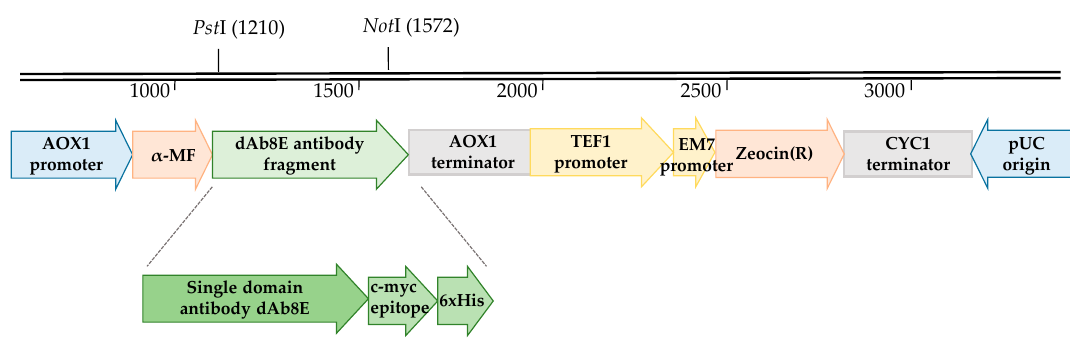
Figure 1. Scheme of the plasmid pMJA302 engineered by inserting the coding sequence of the single-domain antibody (sdAb) fragment dAb8E in the acceptor vector pMJA282. This plasmid was used to produce the recombinant antibody dAb8E against gluten by means of the Pichia pastoris expression system. The single-domain antibody fragment (dAb8E) sequence was cloned in frame with the